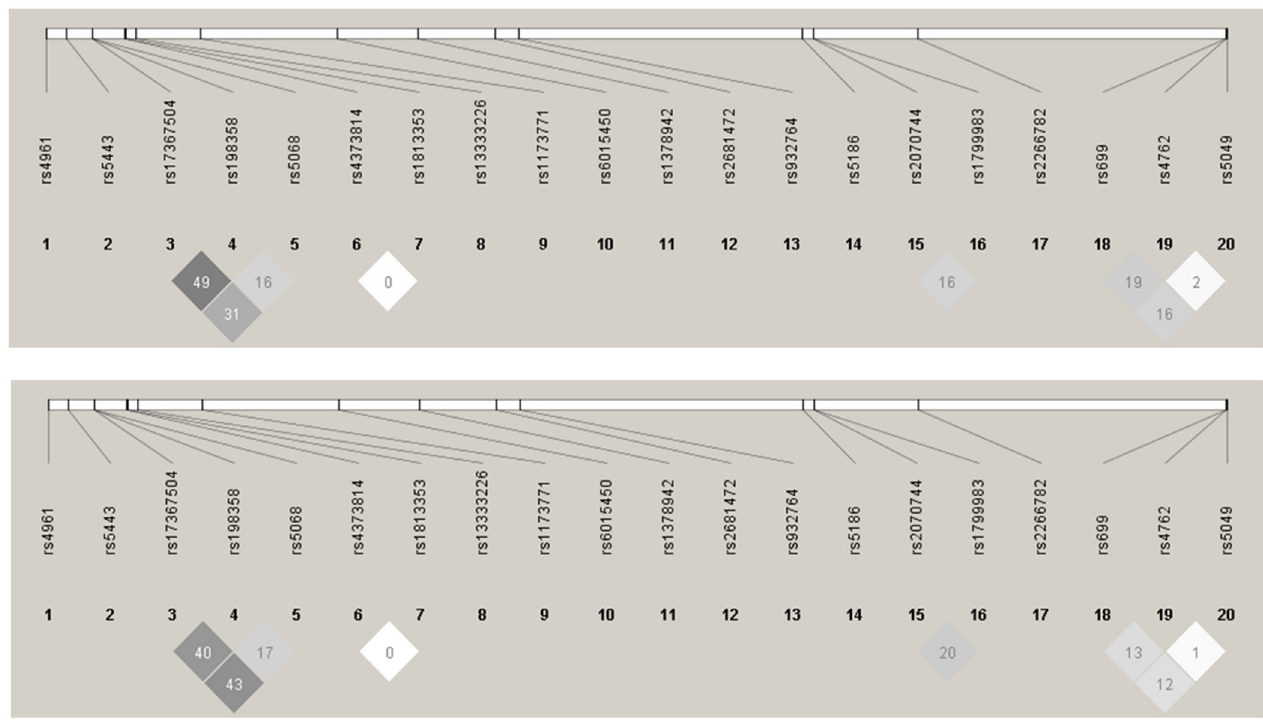
Fig 1. LD pattern of SNPs associated with hypertension for the HG (upper) and HR (lower) populations. Linkage analysis were conducted separately in the study populations. According to the LD map which generated by Haploview software (version 4.1), there were not observed multicollinearity between the polymorphisms, based on the LD pattern none of the pairwise LD of the studied SNPs reached the r 2 threshold of � 0.8, thus it was not necessary to prune SNP from the analysis. The numbers above the LD plot show the rs numbers of SNPs. Numbers in squares are r 2 values. The colour scheme is the r 2 colour scheme (white r 2 = 0, shades of grey 0 < r 2 <